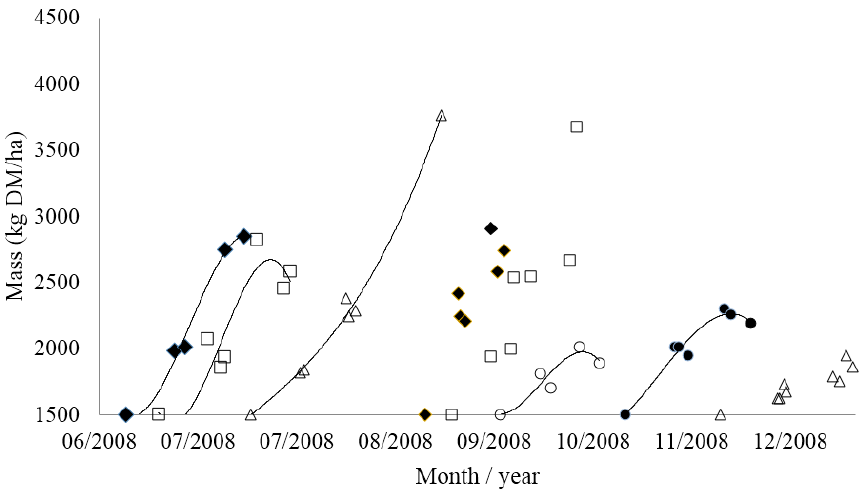
Figure 3. Regrowth curves for perennial ryegrass lamina tissue, derived from data for percentage of total tiller weight comprised by lamina, total herbage mass at the time of sampling, and observed leaf appearance rate data. Fitted lines are third-order polynomials, and are presented only where the polynomial described more of the variation in the data than a linear regression. From [35].